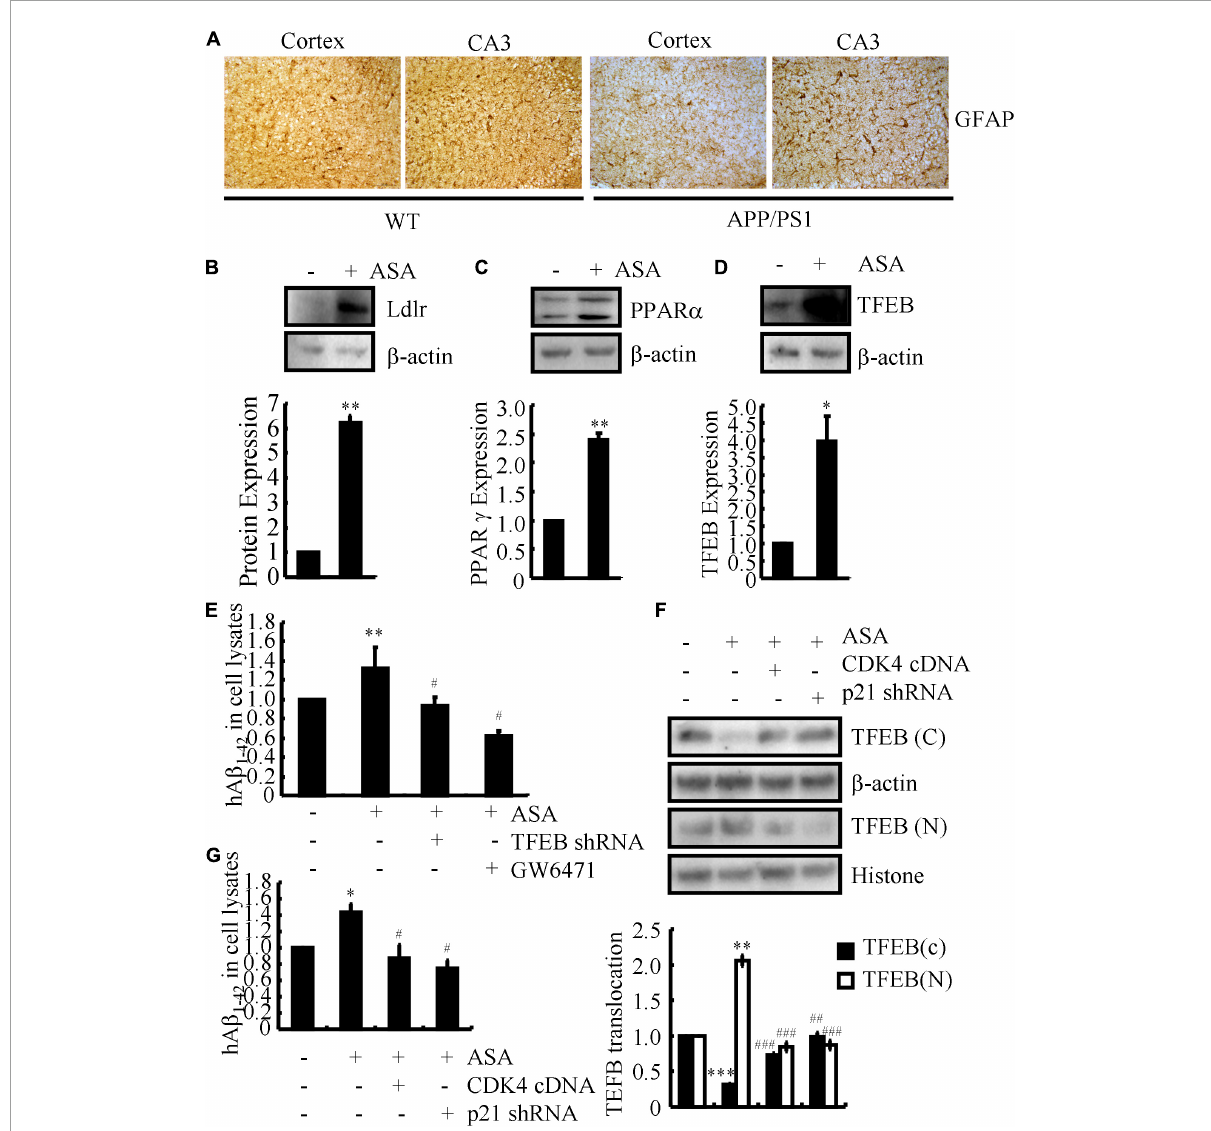
FIGURE5 Aspirin induces the uptake of A β in astrocytes. (A) The brains of WT and APP/PS1 Tg mice were collected and sectioned after paraffin embedding. The morphology of astrocytes were determined by IHC. (B–D) In select experiments, D1A cells were treated with ASA (10 µ M). The protein expression of Ldlr, PPAR α , and TFEB were determined by western blots. β -actin served as an internal control. The optical density of the bands was analyzed using ImageJ software. (E) In separate experiments, D1A cells were transfected with TFEB shRNA or pre-treated with GW6471 (1 µ M) before incubating in ASA (10 µ M). (F,G) In distinct experiments, D1A cells were transfected with CDK4 cDNA and p21 shRNA before incubating with ASA (10 µ M). (E–G) The uptake of A β 1 − 42 was determined by ELISA. (F) The protein levels of TFEB in cytosol and nucleus was determined by western blots. β -actin and histone served as internal controls. The optical density of the bands was analyzed using ImageJ software. Data are presented as the means ± S.E. of independent experiments, ∗ p < 0.05; ∗∗ p < 0.01; ∗∗∗ p < 0.001 compared to vehicle-treated controls, # p < 0.05; ## p < 0.01; ### p < 0.001; compared to ASA-treated